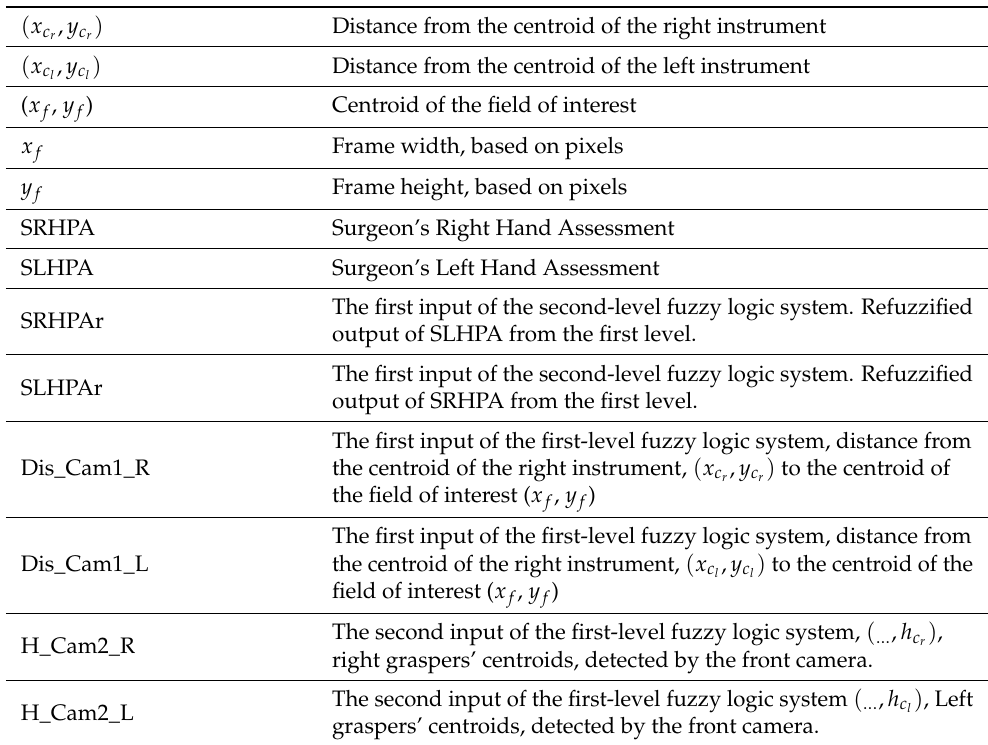
Table 2. Rule list—first-level fuzzy logic